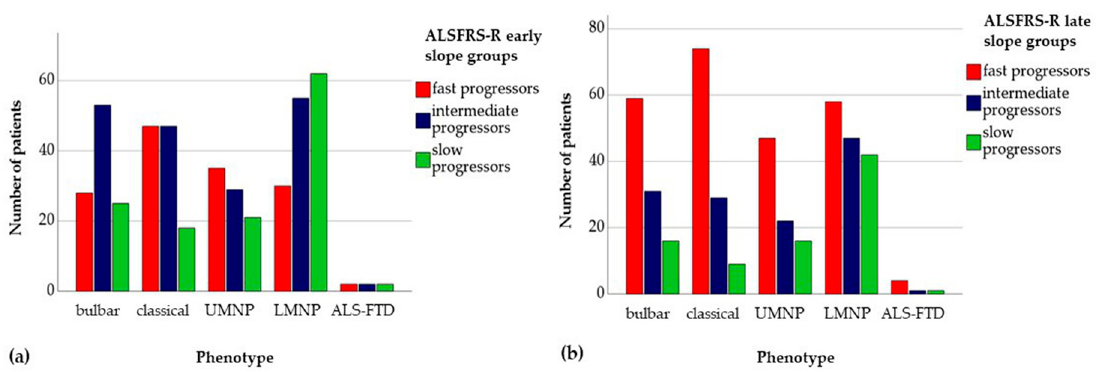
Figure 2. Distribution of ALS phenotypes according to disease progression rate as reflected by ( a ), ALSFRS-R early slope, and ( b ), ALSFRS-R late slope. ALS = amyotrophic lateral sclerosis; ALSFRS-R = revised ALS Functional Rating Scale; ALS-FTD = ALS with frontotemporal dementia; LMNP = lower motor neuron predominant; UMNP = upper motor neuron predominant.